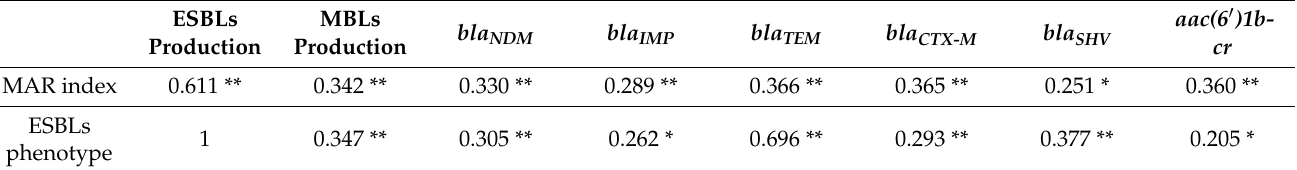
Table 6. Correlation matrix (r 2 ) between phenotypes, genotypes and antibiotic resistance across the E. coli isolates.